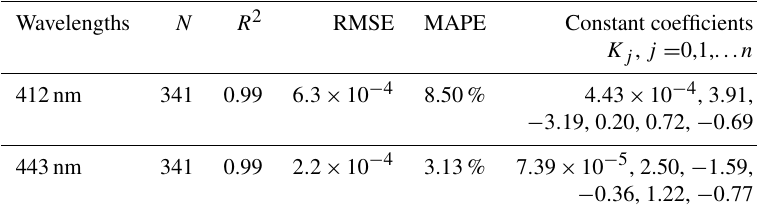
Table 3. Statistical parameters and coefficients for the algorithm to reconstruct R rs